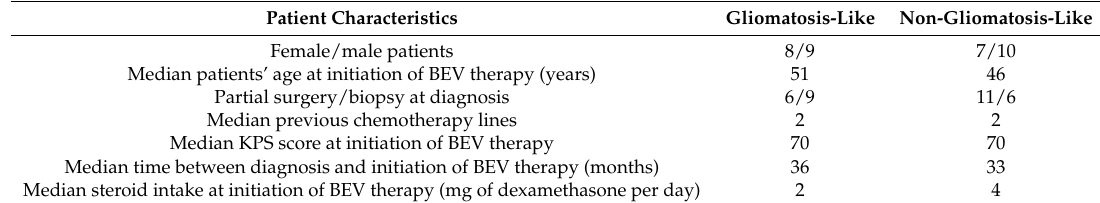
Table 5. Comparison of patient